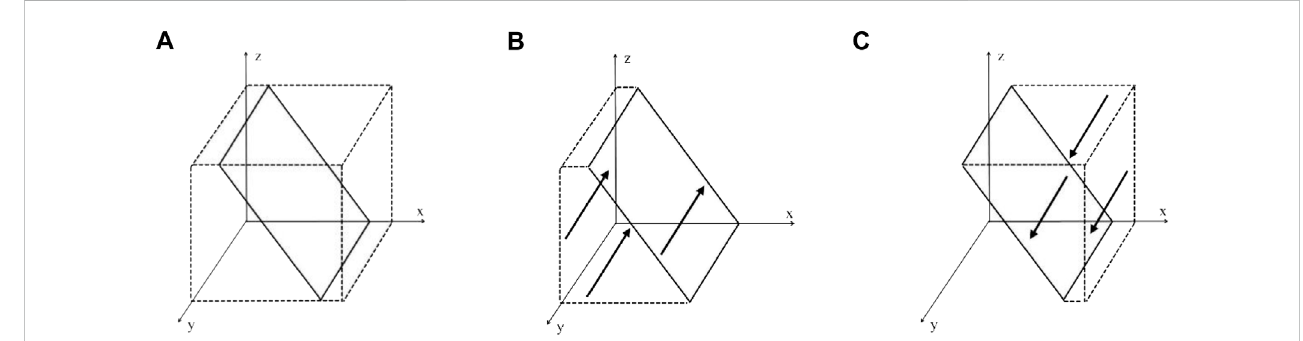
FIGURE 3 Dynamic evolution phase diagrams of SM building material manufacturers.